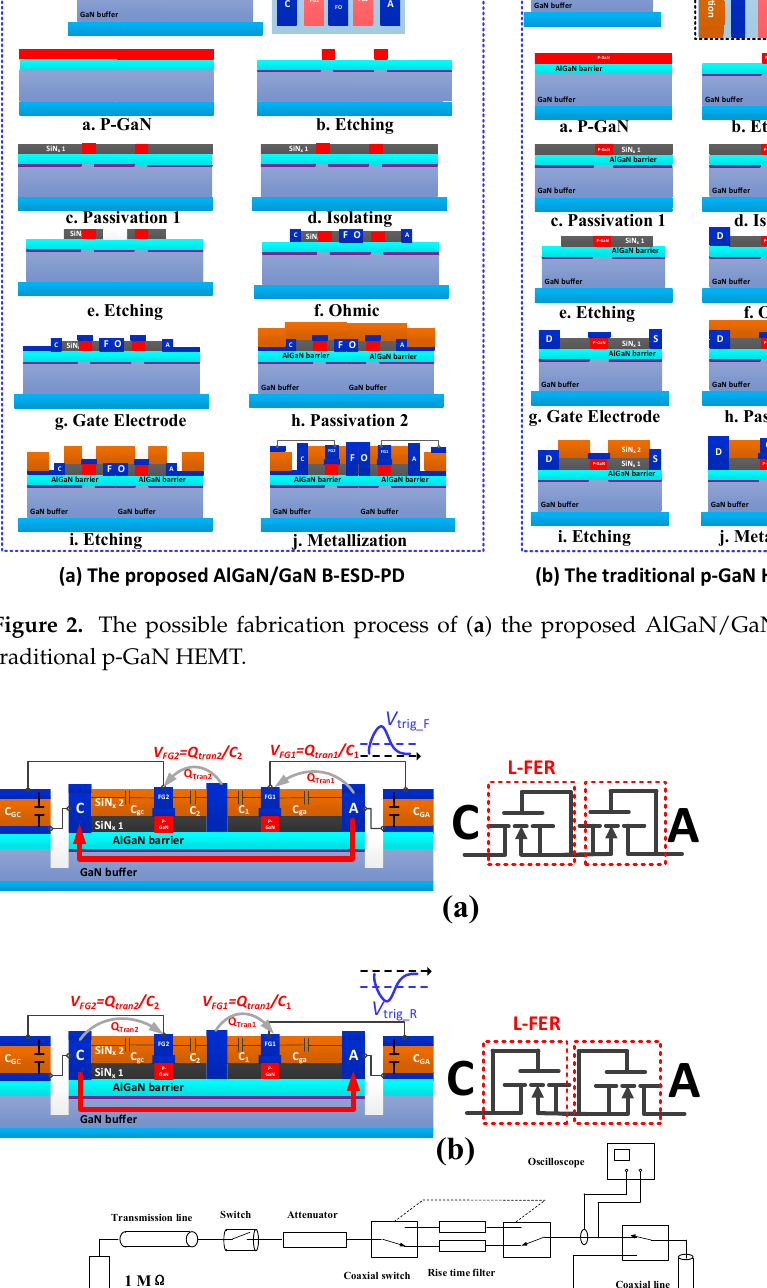
Figure 1. ( a ) The schematic structure and ( b ) equivalent circuit of the proposed AlGaN/GaN B-ESD- PD. ( c ) The equivalent structure configured using the chip capacitor and the commercially p-GaN HEMT (EPC2036) from the EPC Corporation [20].